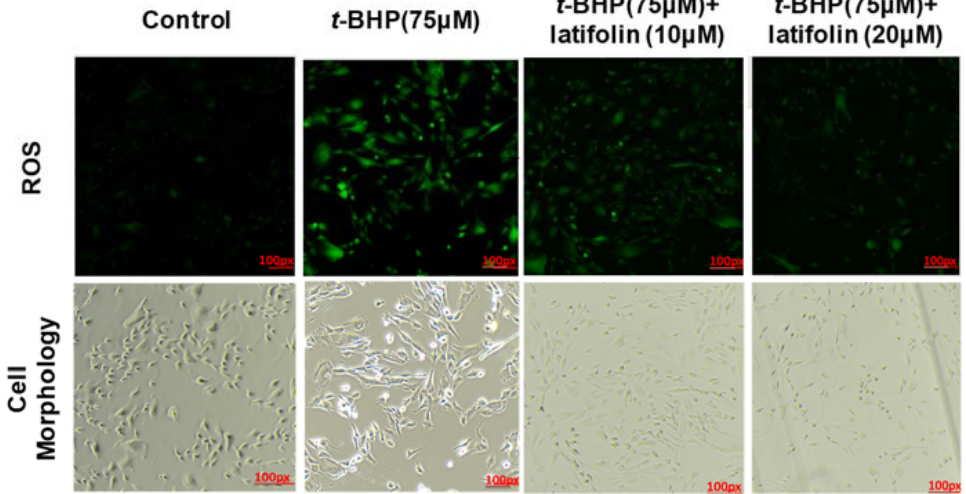
Figure 6. E ff ects of latifolin on ROS production induced by t -BHP in BJ-5ta cells. After pretreatment with latifolin for 3 h, ROS generation was detected in the absence or presence of t -BHP for 24 h using fl uorescence microscope (original magni fi cation: ×100).